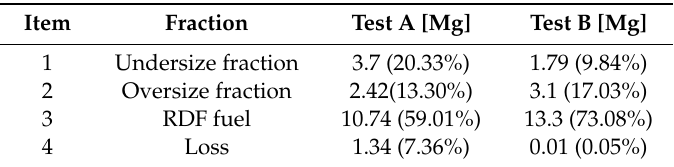
Table 3. The results of the carried out tests (A and B)—result of application the classic control algorithm (Test A) and using the author’s algorithm presented in Section 3.1.1.1 (Test B).